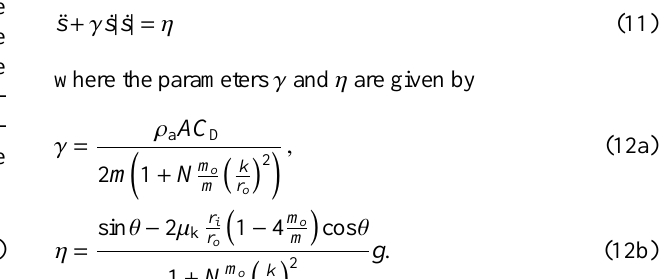
summing the moments about an axis through A and